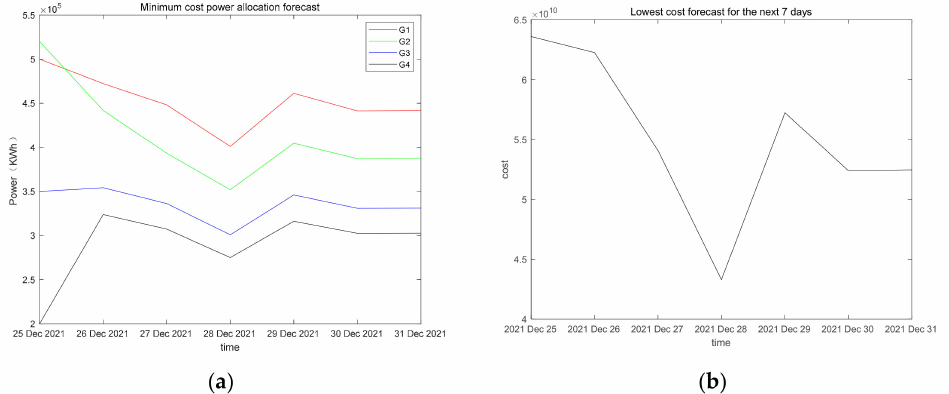
Figure 12. The minimum power is its power distribution. ( a ) Microgrid power distribution at the lowest cost; ( b ) The lowest cost of microgrid output power for the next 7 days.